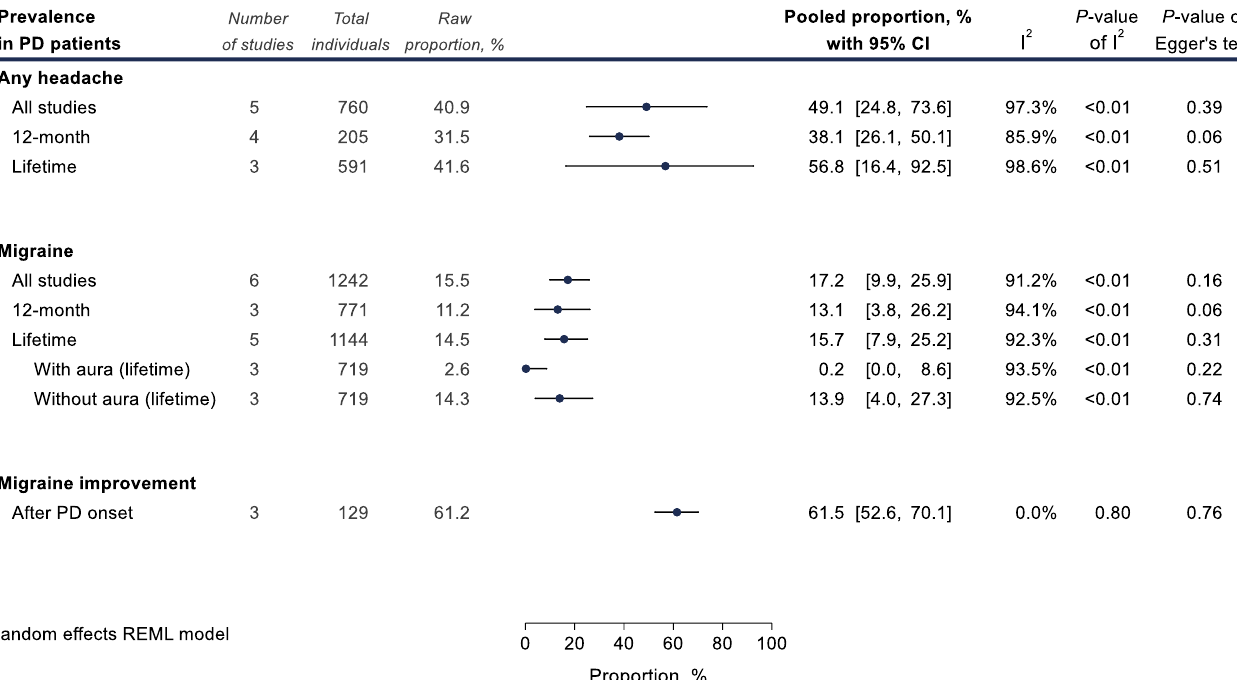
Figure 2. Meta-analyses of proportions examining headache prevalence (%) among Parkinson’s disease (PD) patients. Results of each individual random effects meta-analysis are depicted as black data markers; 95% confidence intervals (CI) are indicated by the black error bars. I 2 reflects each meta-analysis heterogeneity.